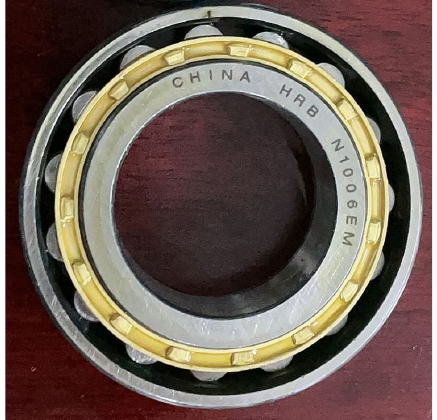
Figure 9. The fault simulation platform.